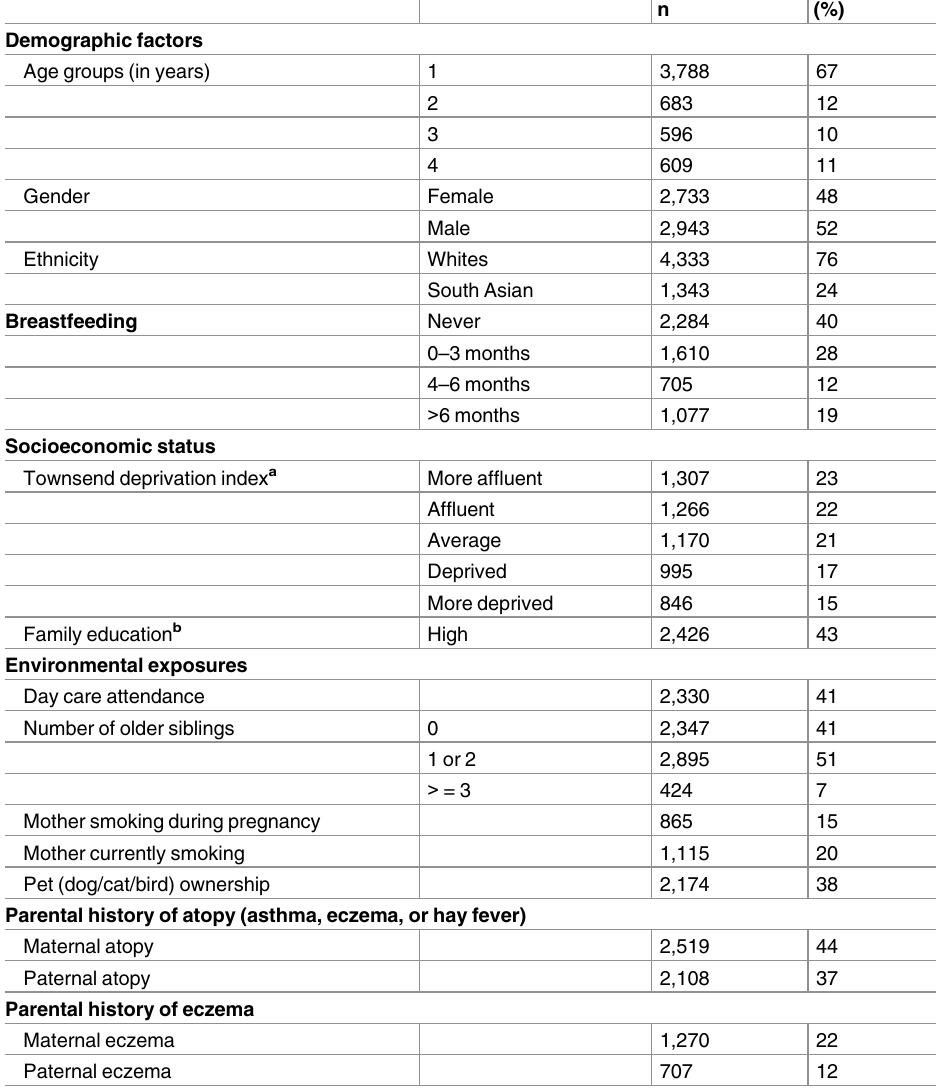
a An area-based deprivation score; higher values indicate greater deprivation.